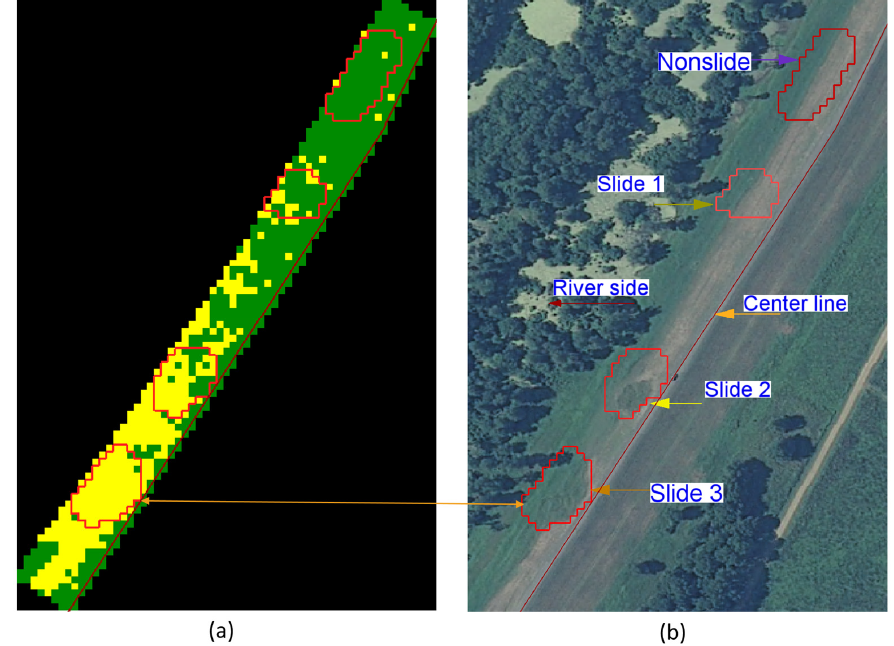
Figure 9. ( a ) Maximum likelihood classification; and ( b ) optical image; overlaid with the levee center line, slide, and non ‐ slide areas.